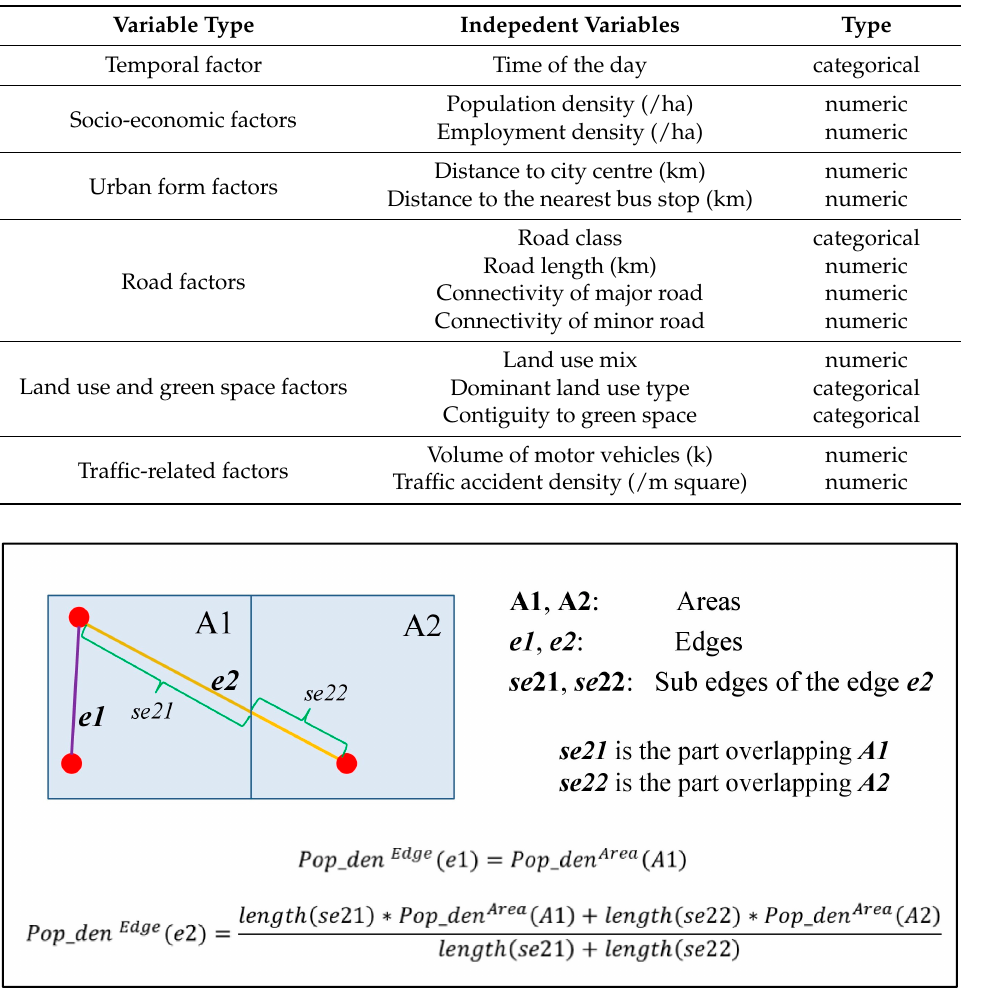
Table 3. Independent variables considered in this study.